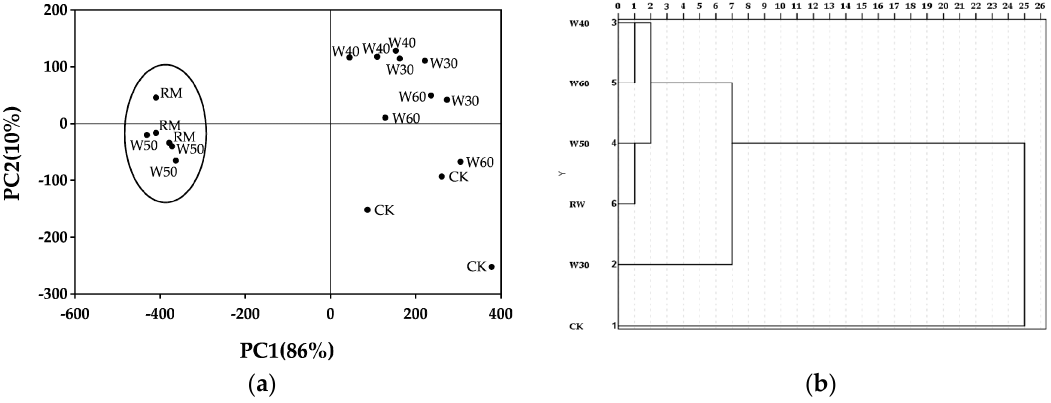
Figure 3. Classification of all skim milk samples preheated at different temperature : ( a ) Score plot after PCA of the samples. ( b ) Dendrogram from CA of the samples.